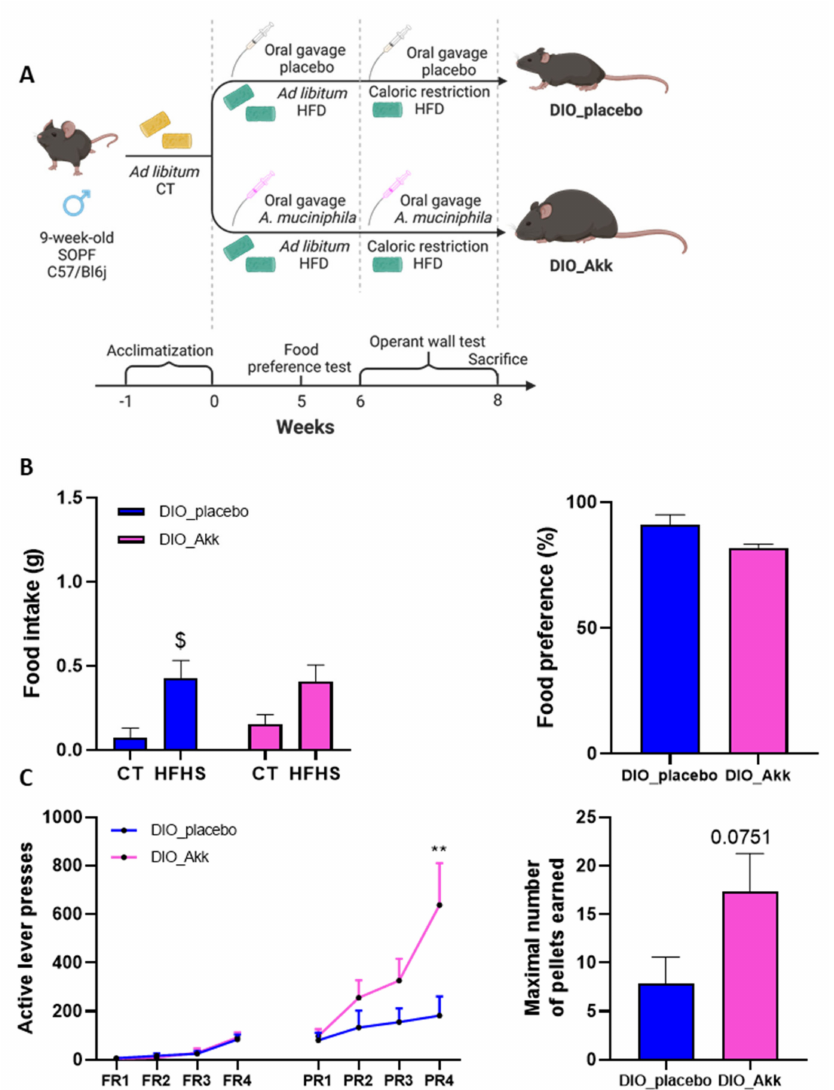
Figure 3. A. muciniphila administration improves the motivational component of food reward associ- ated with obesity. ( A ) Experimental plan of the experiment 1. Created with BioRender.com. ( B ) Food preference test showing HFHS and CT intake in grams and preference for HFHS in percentage after 3 h of test by DIO mice treated with placebo (DIO_placebo) and A. muciniphila (DIO_Akk). ( C ) Oper- ant conditioning test showing the number of active lever presses during the four progressive ratio (PR) sessions and the maximal number of pellets earned during the PR4 by DIO mice treated with placebo (DIO_placebo) and A. muciniphila (DIO_Akk). The percentage of food preference was calculated based on HFHS intake (g) during the food preference test divided by the total food intake (g) eaten during the food preference test. Data are shown as mean ± SEM. p -values were obtained after two-way ANOVA followed by Bonferroni post-hoc test. ( n = 7/group) ( B ) after two-way ANOVA repeated measure followed by Bonferroni post-hoc test ( n = 6/group) ( C ) after unpaired Student’s t -test